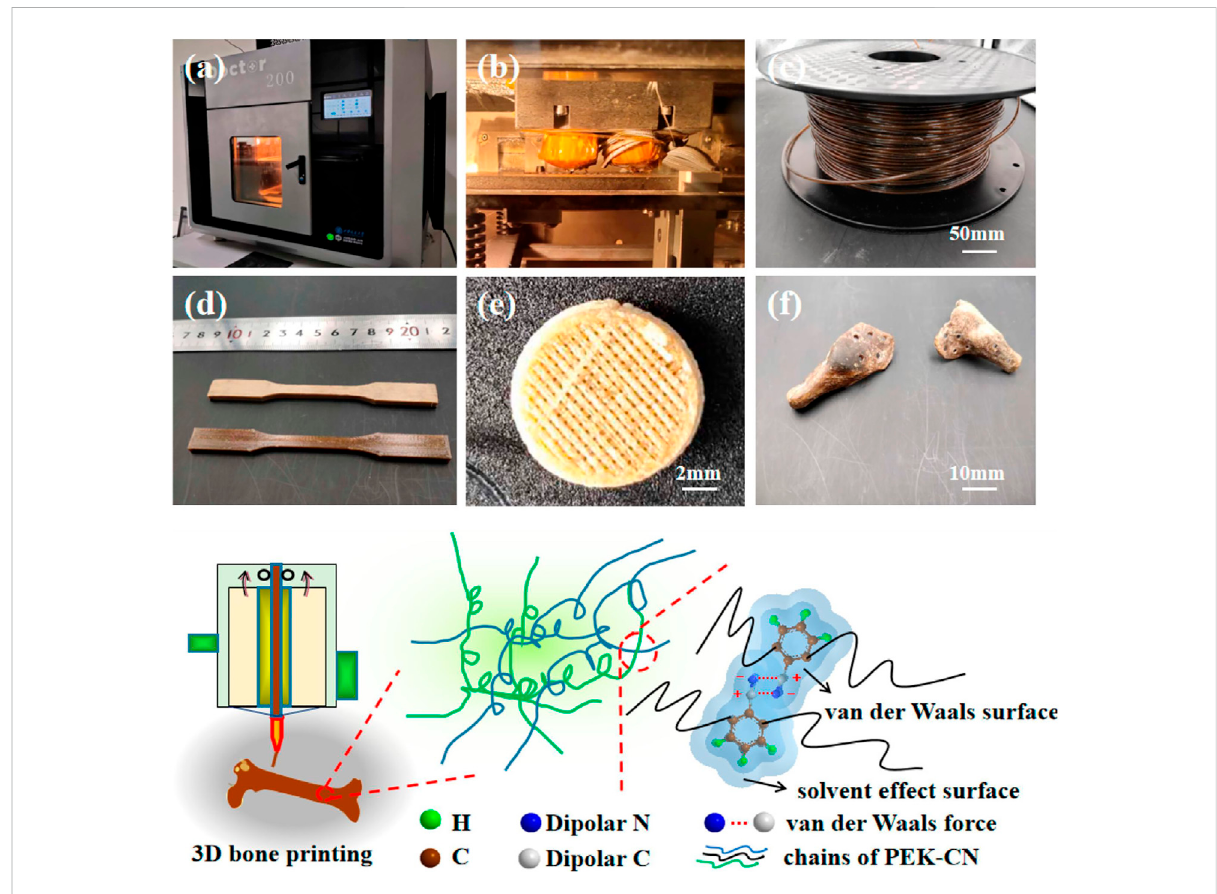
FIGURE 4 Amorphous poly (aryl ethernitrileketone) and itscompositeswith nano hydroxyapatitefor printing arti fi cialbone. Reproducedwith permission from ref (Gao et al.,